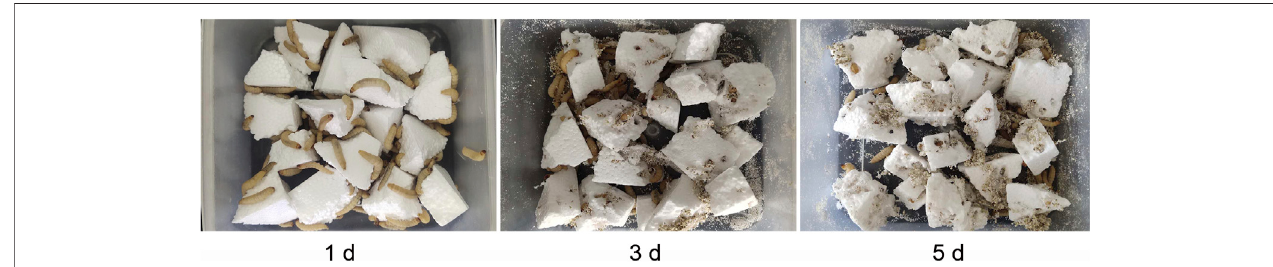
FIGURE 2 | Holes formed by G. mellonella larvae after feeding on PS foam for 1, 3 and 5